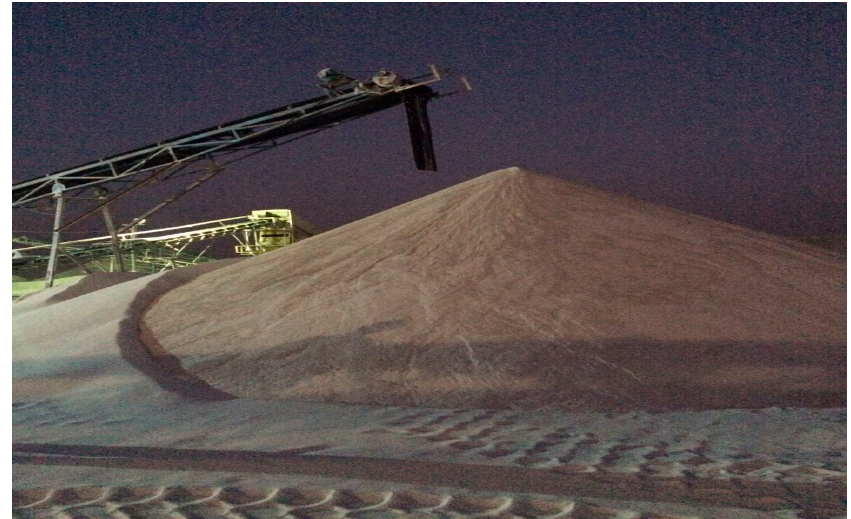
Figure 2. One of the stockpiles of waste sand produced in the Al-ahsa quarries, Riyadh Road, Saudi Arabia.